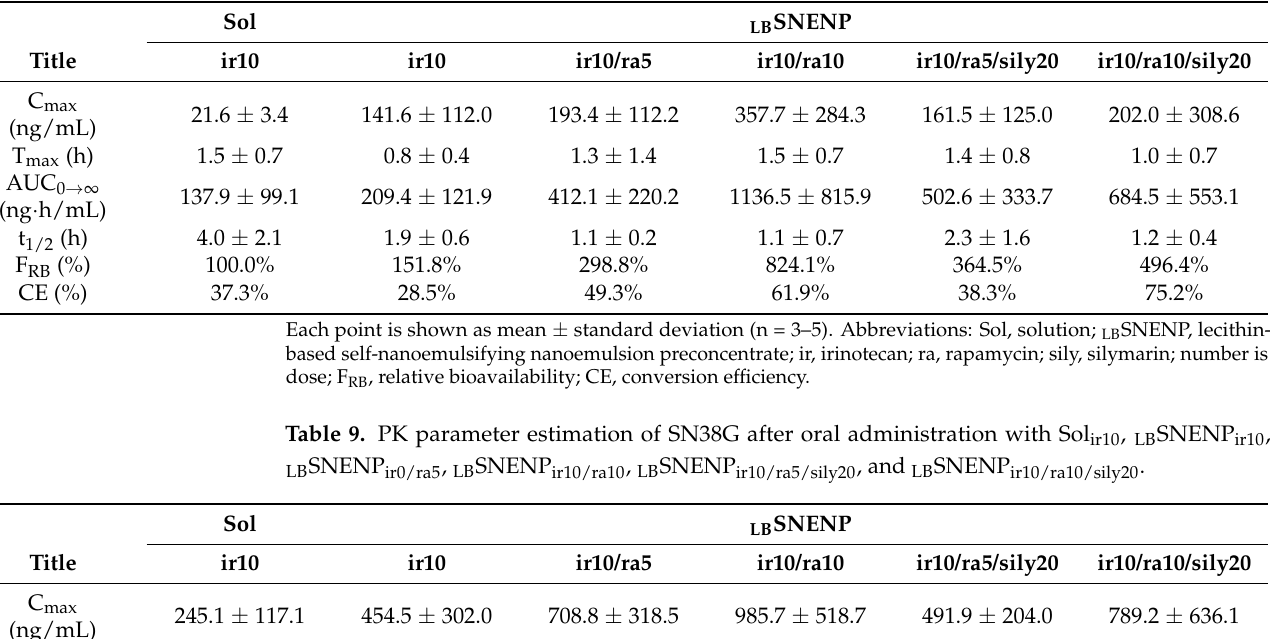
Table 8. PK parameter estimations of SN38 after oral administration with Sol ir10 , LB SNENP ir10 ,